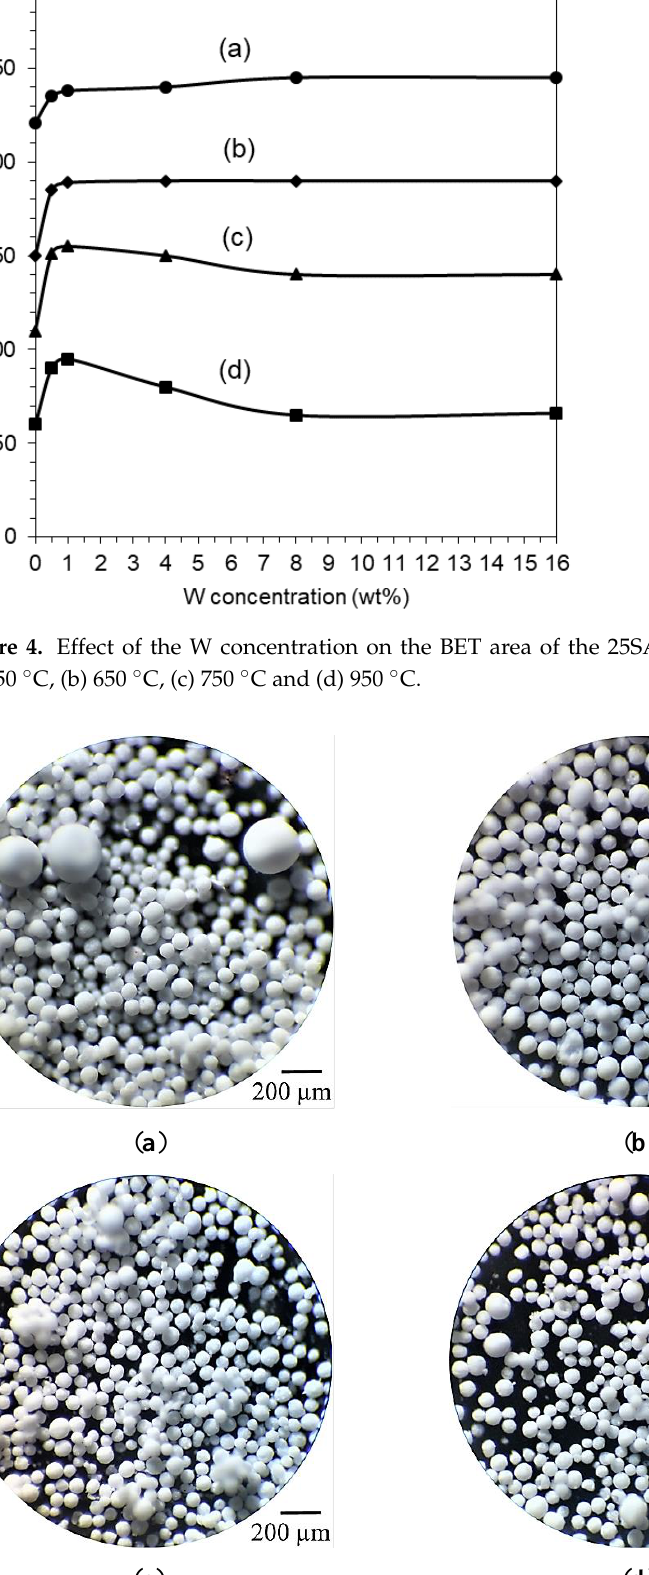
Figure 5. Optical microscopy of the spray-dried 25SA microspheres calcined at 550 °C was ob- tained with the straight rectangular vanes disk: ( a ) P1‒DAR, ( b ) P2‒DAR, ( c ) P3‒DAR y ( d ) P4‒